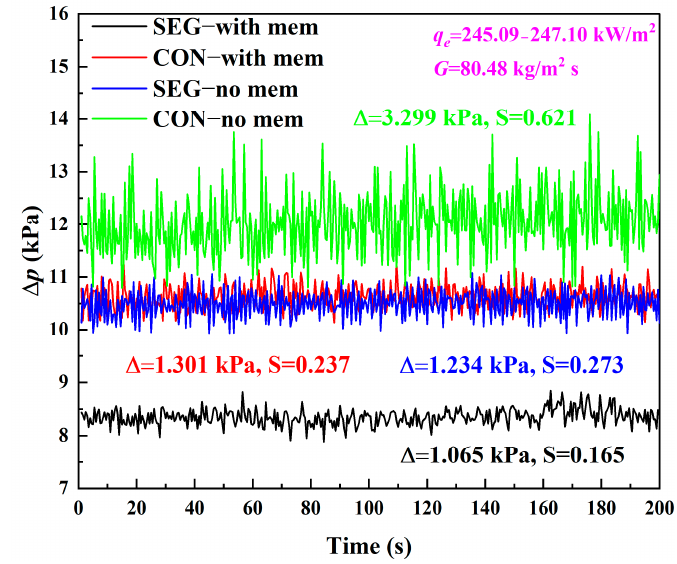
Figure 13. Pressure drop fluctuations in the continuous and segmented heat sinks with and without the venting membrane.